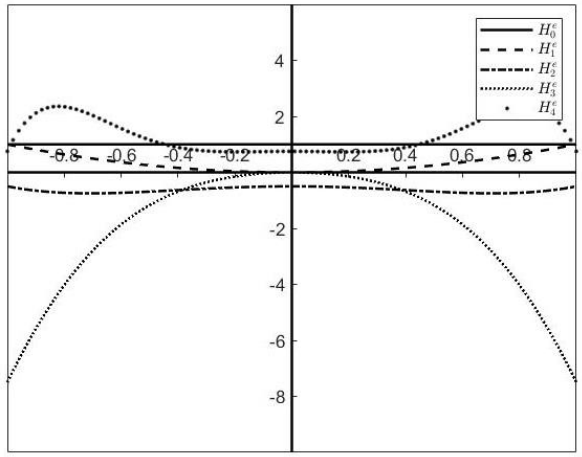
Figure 5. Even Hermite-central factorial